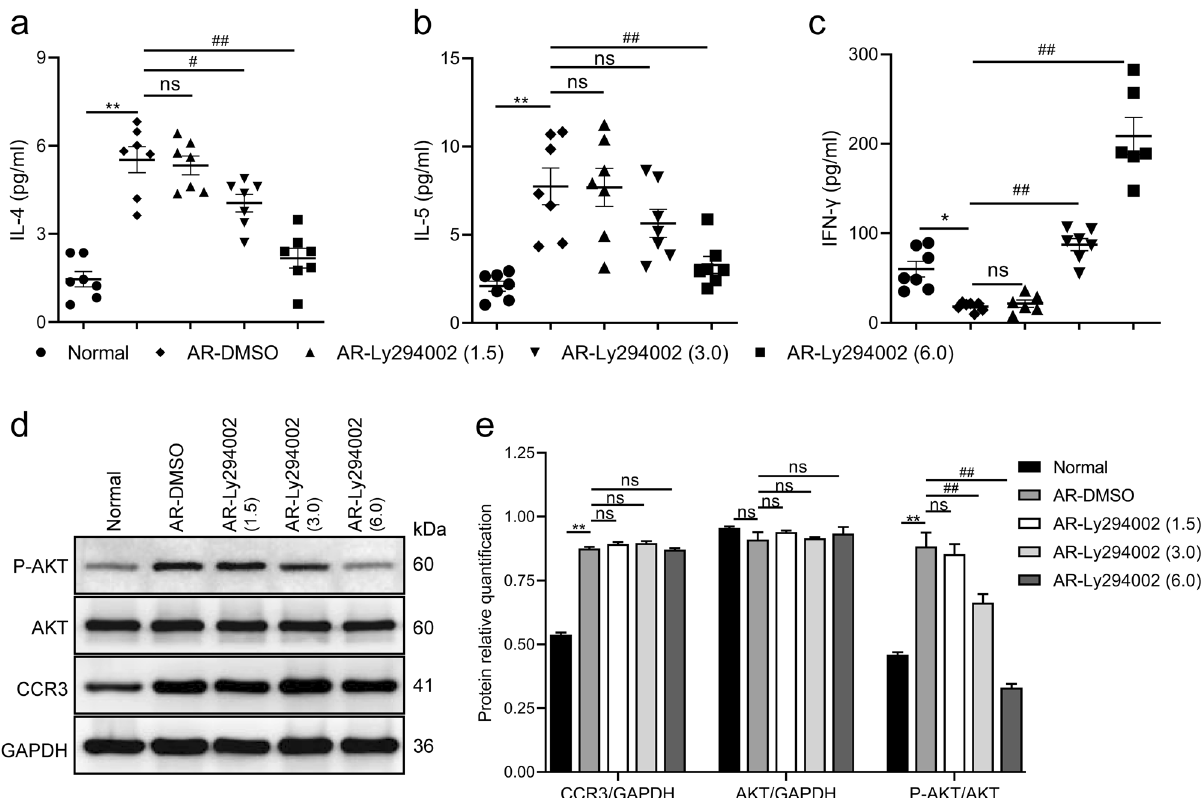
Figure 4. Effects of Ly294002 on the levels of Th1 and Th2 cytokines and the protein contents of CCR3, AKT and P-AKT. The levels of IL-4 ( a ), IL-5 ( b ) and IFN-γ ( c ) in serum using ELISA. Representative Western blot images ( d ). Relative protein quantifications of CCR3, AKT and P-AKT in the nasal mucosa ( e ). Data are expressed as the means ± SEM. * P < 0.05, ** P < 0.01 vs. the normal group; # P < 0.05, ## P < 0.01 vs. the AR-DMSO group, ns indicates P >